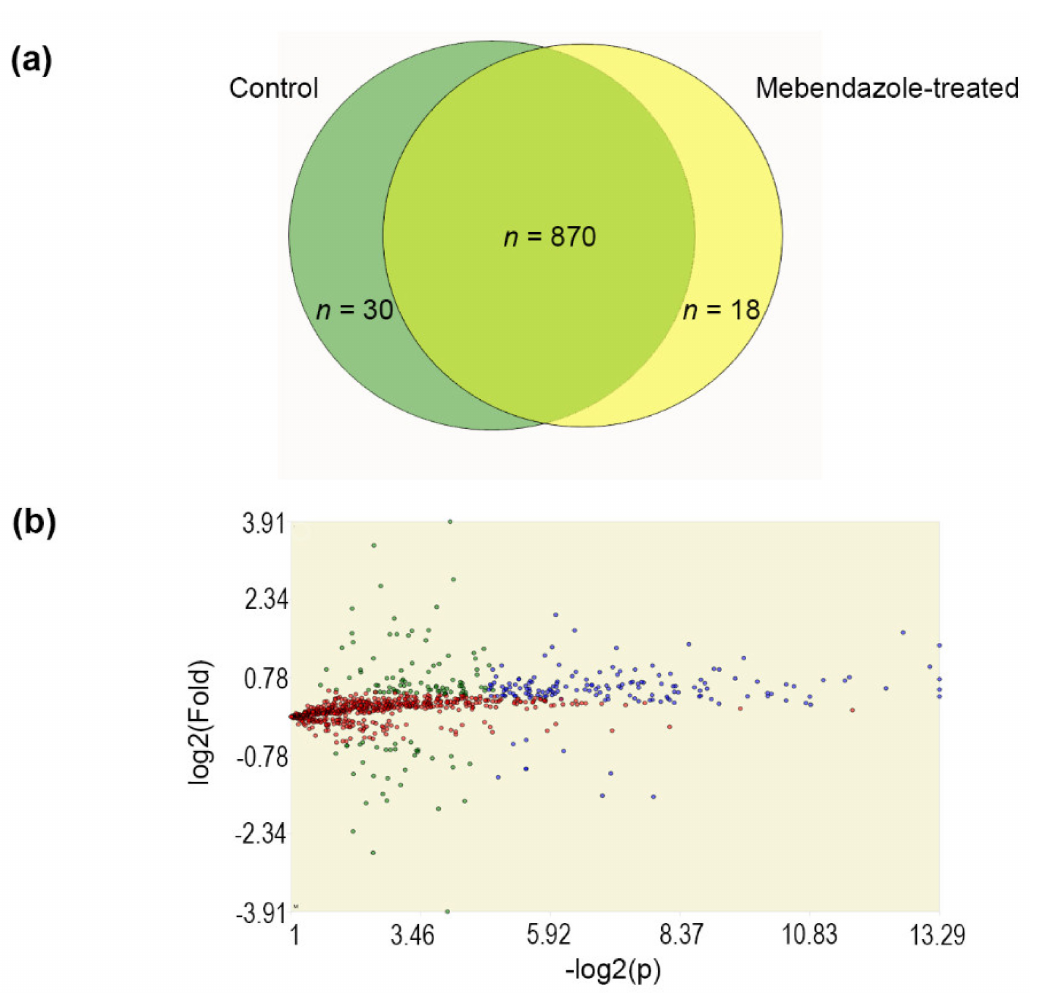
Figure 2. Proteomics of mebendazole-treated H. capsulatum : ( a ) Venn diagram showing the number of proteins present, in both technical replicates of at least three biological replicates, of control proteome, with DMSO (green) and mebendazole-treated proteome (yellow) that were detected in both technical replicates of at least three biological replicates; ( b ) Volcano plot of 870 proteins present in both proteomes. Blue dots indicate proteins that satisfied fold and statistical criteria ( n = 159), green dots indicate proteins that satisfied the fold criteria but, most likely, this happened by chance ( n = 121), and red dots indicate proteins whose identifications did not meet the fold and p -value criteria ( n = 590). Green and red proteins were excluded from further